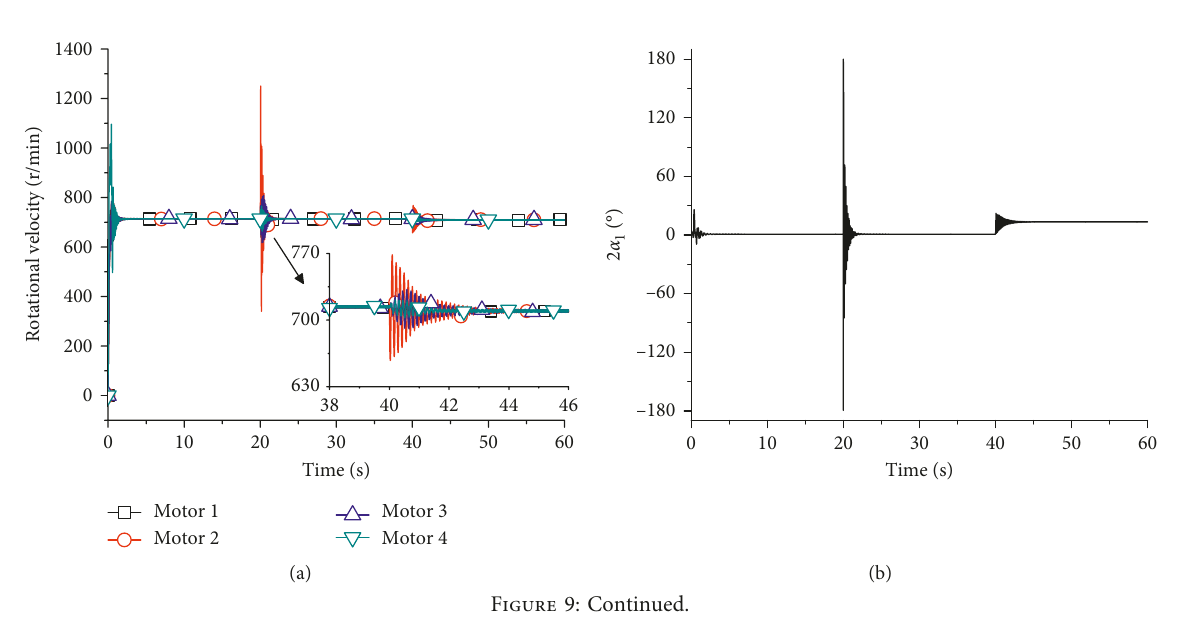
The results of characteristic analysis data from Figure